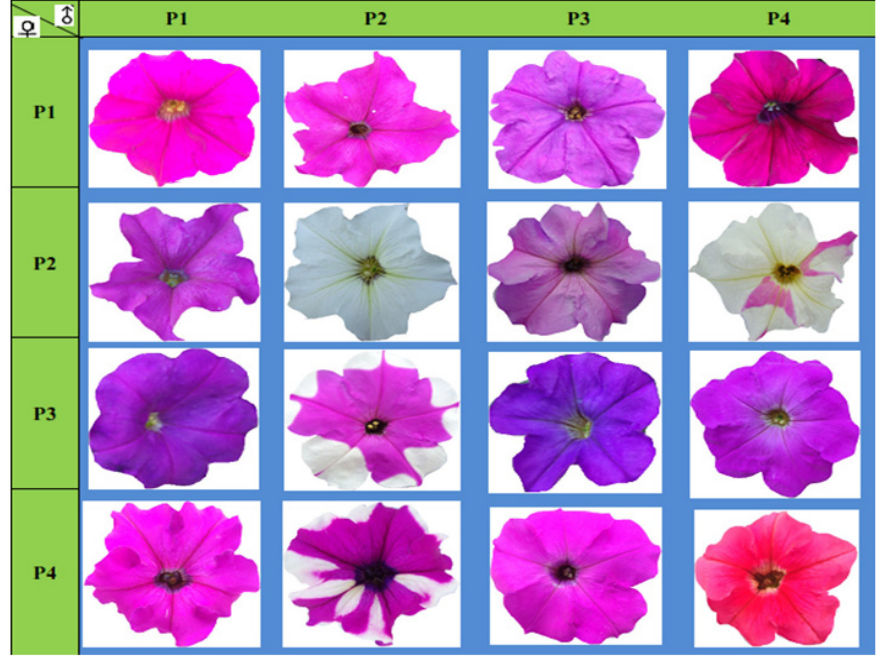
Fig. 3. Flowers of the four parents (diagonal), 6 hybrids (upper of diagonal) and 6 reciprocal hybrids (lower of diagonal) of petunia. The letters P1 to P4 indicate the four parental